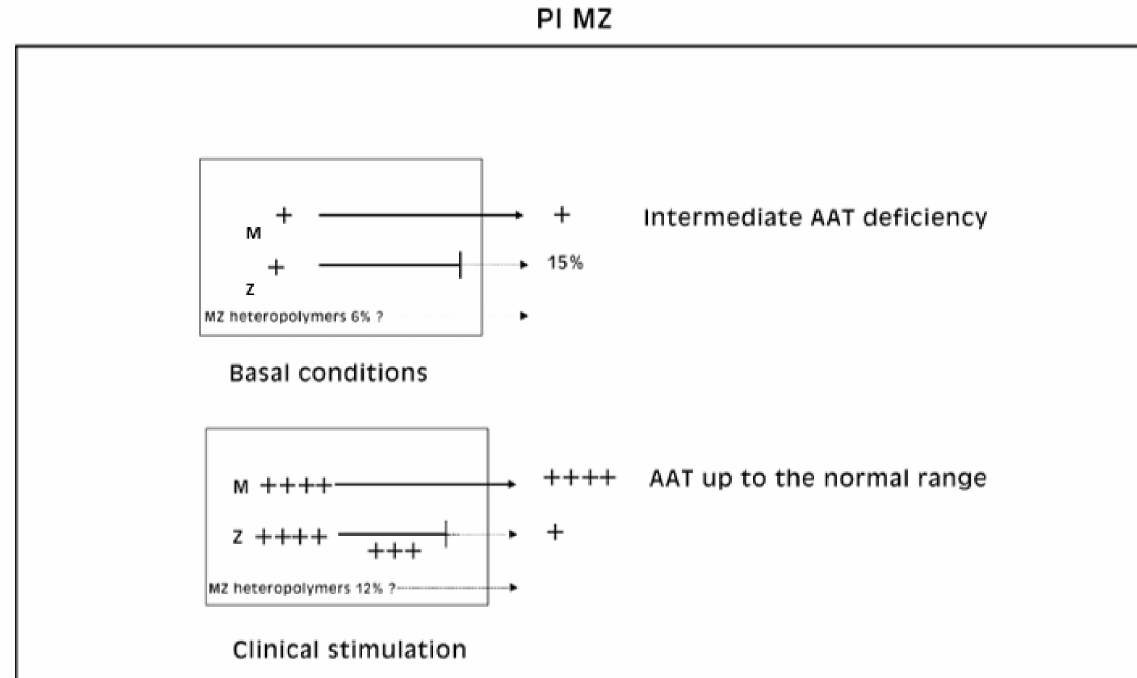
Figure 12. Schematic representation of the “R-SB” phenomenon in Pi MZ phenotype in the light of M-Z heteropolymerization. By comparing this scheme with that in Figure 1a, it appears the in basal condition, the total amount of AAT results from M, Z and M-Z polymers, respectively estimated as 50%, 15%, 6% (upper panel). Under conditions of clinical stimulation, presumably, there is an increase of the percentage of all components (lower